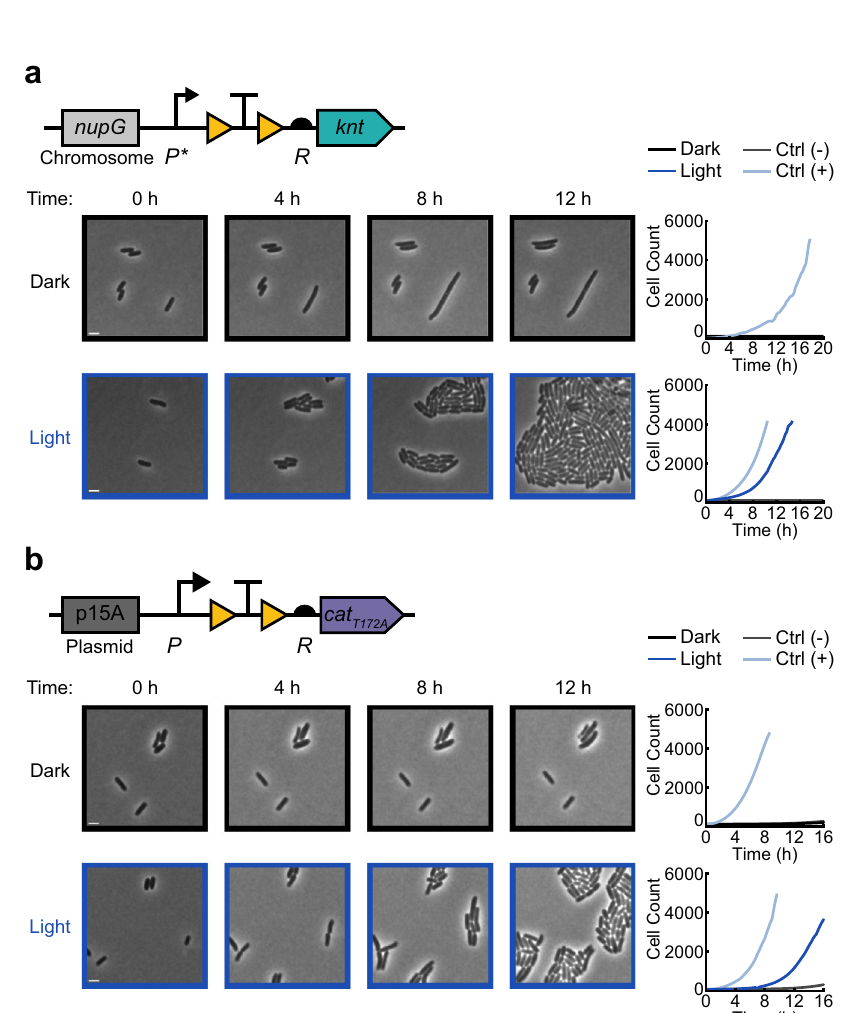
Fig. 4 | Optogenetic activation of ef fl ux-based tetracycline resistance with OptoCre- tetA . a Tetracycline resistance gene tetA is expressed using the native promoter P tet and native RBS R tet , to allow maximal expression of the gene. b MIC curves of OptoCre- tetA on the chromosome and c p15A plasmid origin ( n =3).